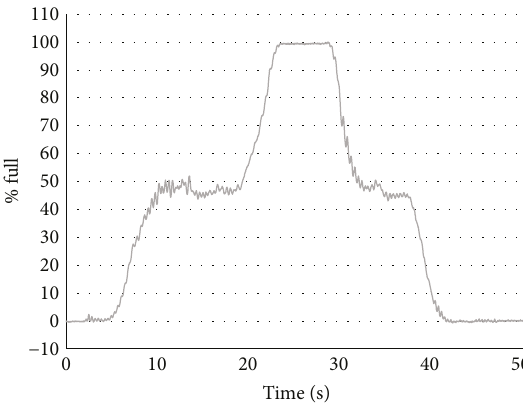
Figure 5: Mass (as % full) from ECT measurements in one-half of the tank.